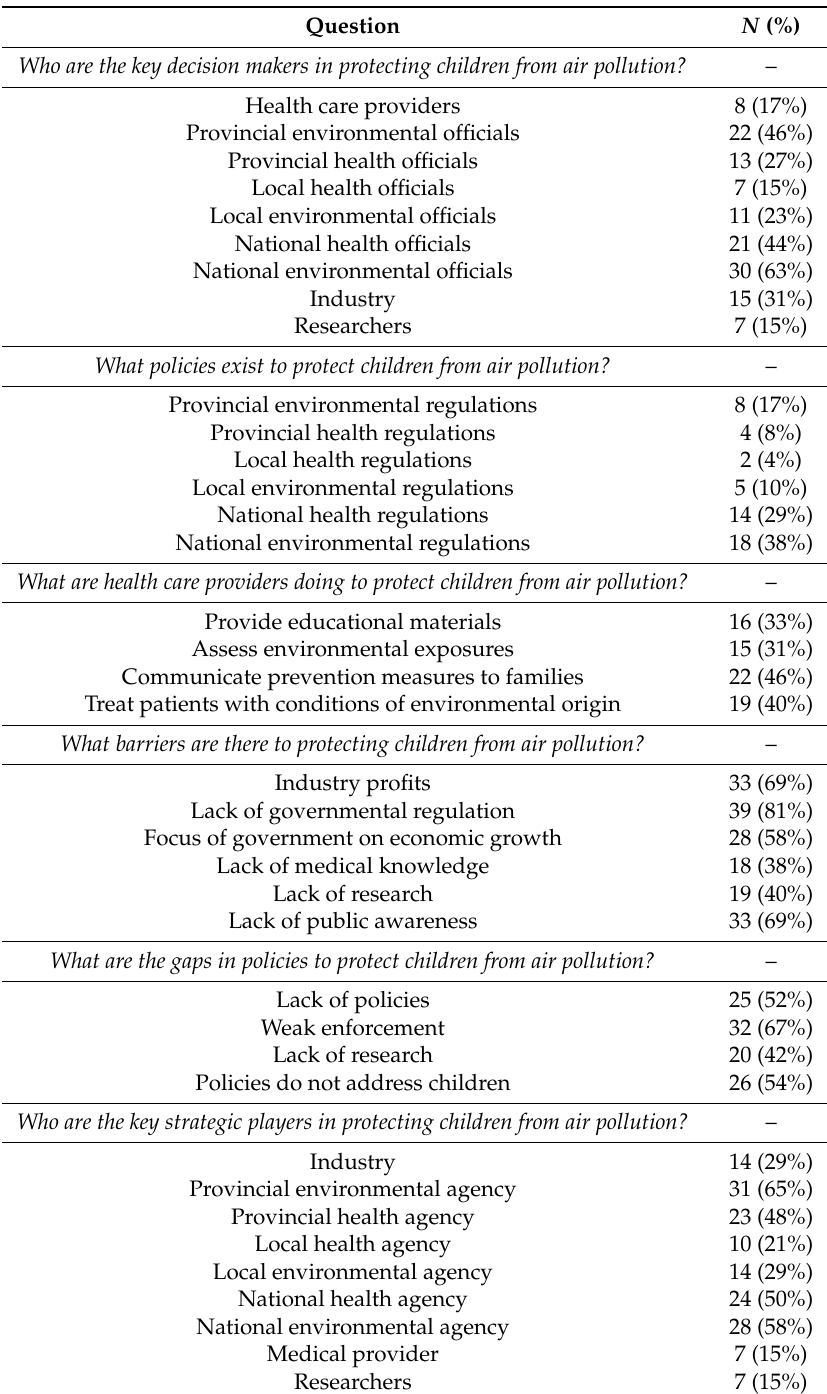
Table 5. Conference participant perspectives about key decision makers and opportunities to protect children from air